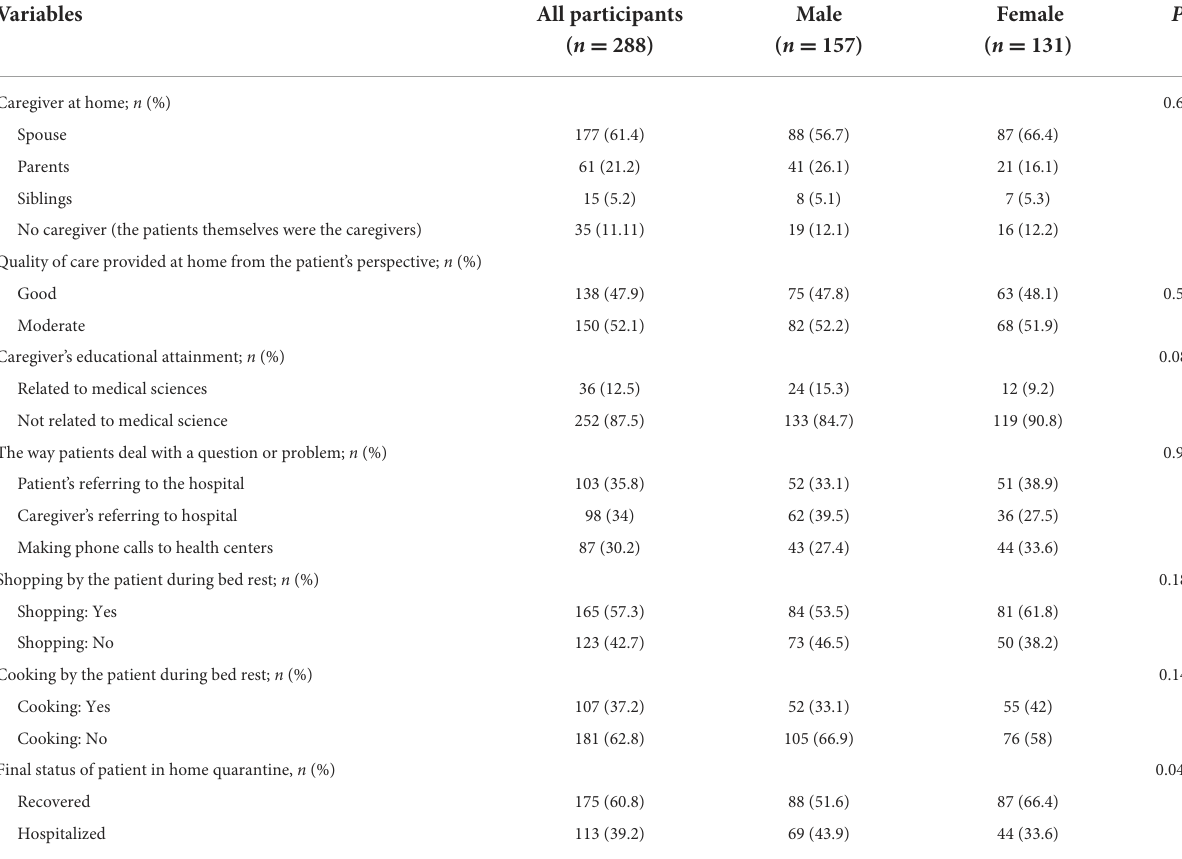
TABLE 4 Patient evaluation of the type of care provided during home quarantine.